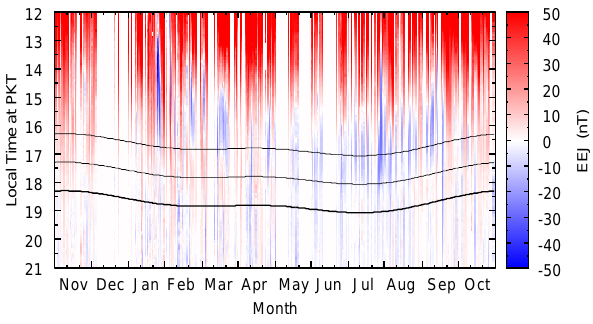
Fig. 4. Contour plot of the EEJ ground strength during the period from November 2007 to October 2008. The thick curve indicates sunset at E-region height. Two thin curves indicate the local-time of 2h and 1h prior to sunset,